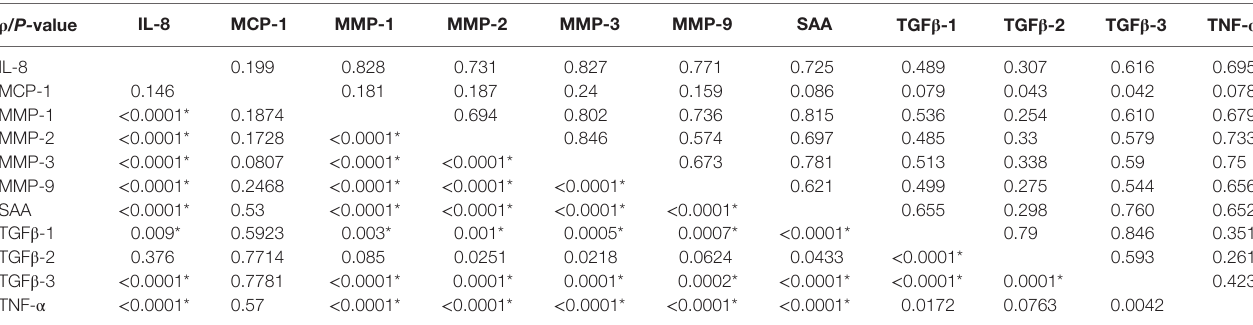
Table 2 | Correlation between cytokines.